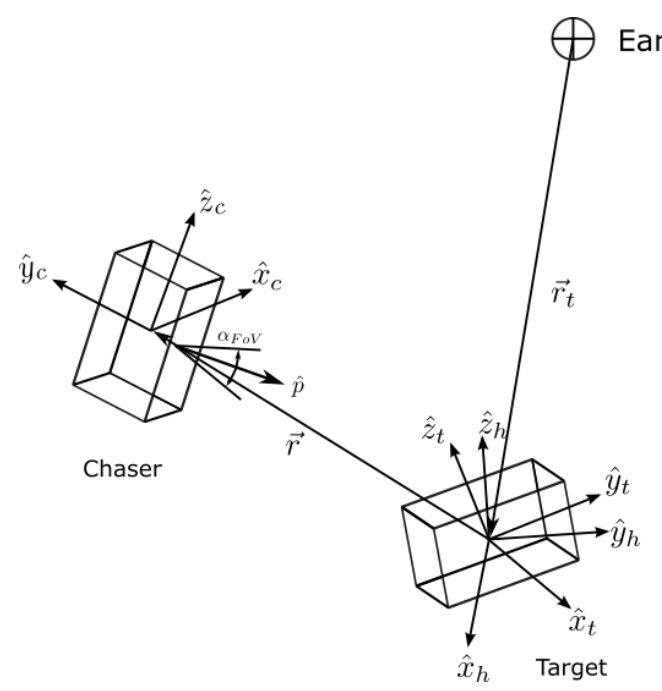
Figure 1. RVD geometry and coordinate